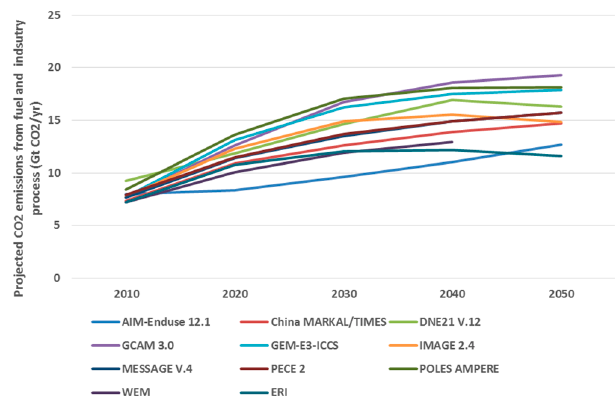
Figure 1. China’s CO 2 emissions, 2010–2050, projected by Reference Scenarios. Source: See Table A1 for data sources for each scenario in Appendix A.